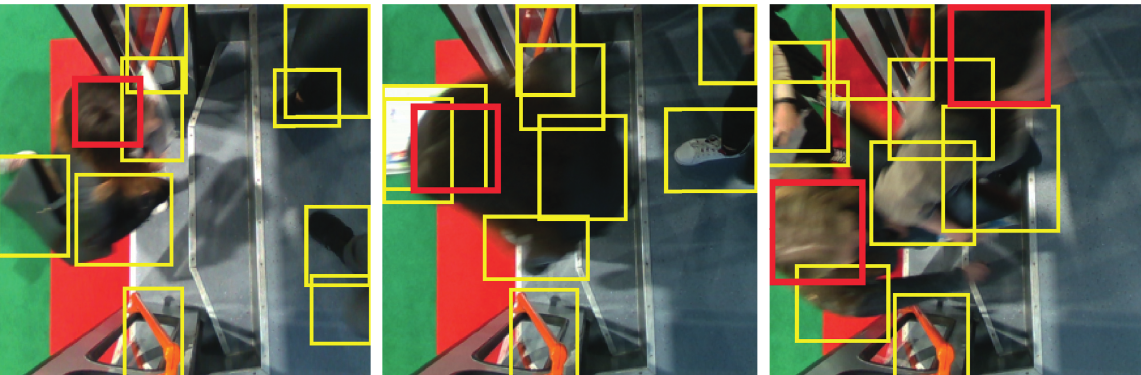
Figure 5: Detection of passengers in orthogonally acquired video data. Candidate object images proposed by a search algorithm (yellow rectangles) are tested. Some of them are classified as “head” (red rectangles), which represents the locations of